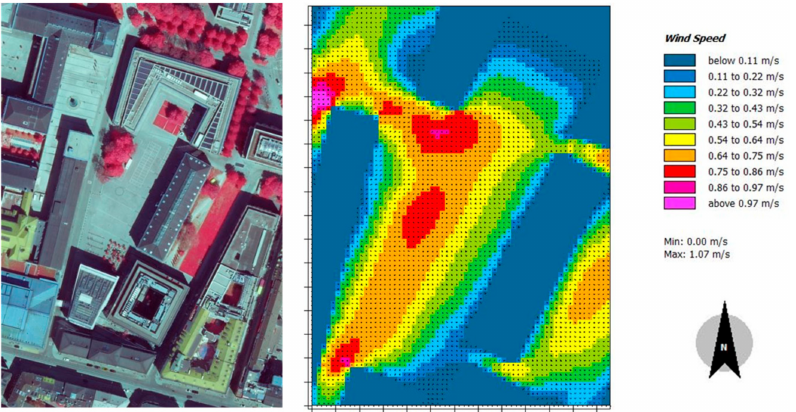
Figure 16. Aerial view and 8 am wind speed simulation of Marstallplatz (Source: Bayerische Vermessungsverwaltung). The air temperature is the variable that most affects the PET on the cold day (at least 82%), and the second variable that most affects the PET is the wind speed (between 88% at 4 pm and 99% at 2 am). The importance of wind protection on cold days is observed in Alter Hof, which shows the highest values of PET during the whole cold period analyzed (Figure 17).